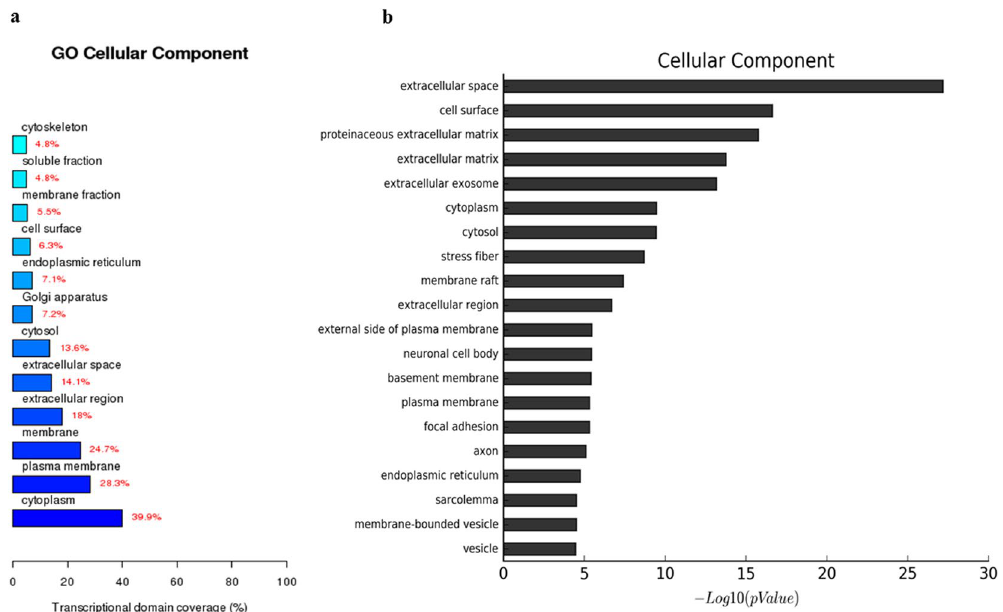
Figure 7. The RCCS-3D vs static-2D group comparison that gene ontology analysis of differentially expressed genes in cellular component. ( a ) Top 20 terms based on most significant p value of biological processes. ( b ) Top 12 terms based on the differential genes were most extensive transcriptional domain